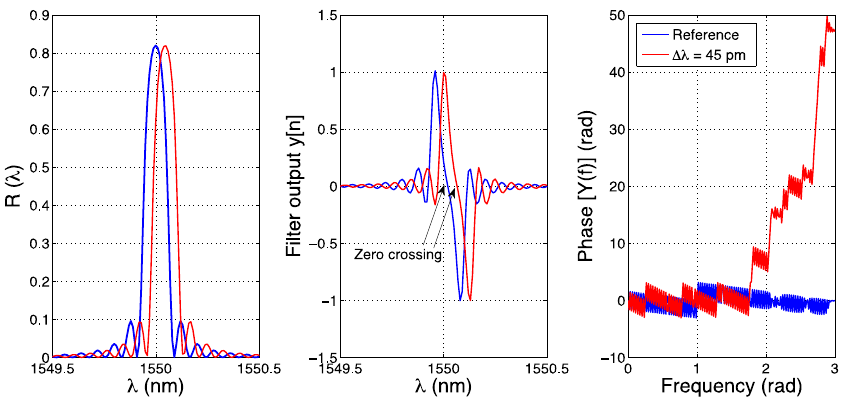
Figure 13. Linear phase operator peak tracking. ( left ) Original spectrum; ( center ) Output of the linear operator filter; ( right ) Phase of the FFT of filter output.